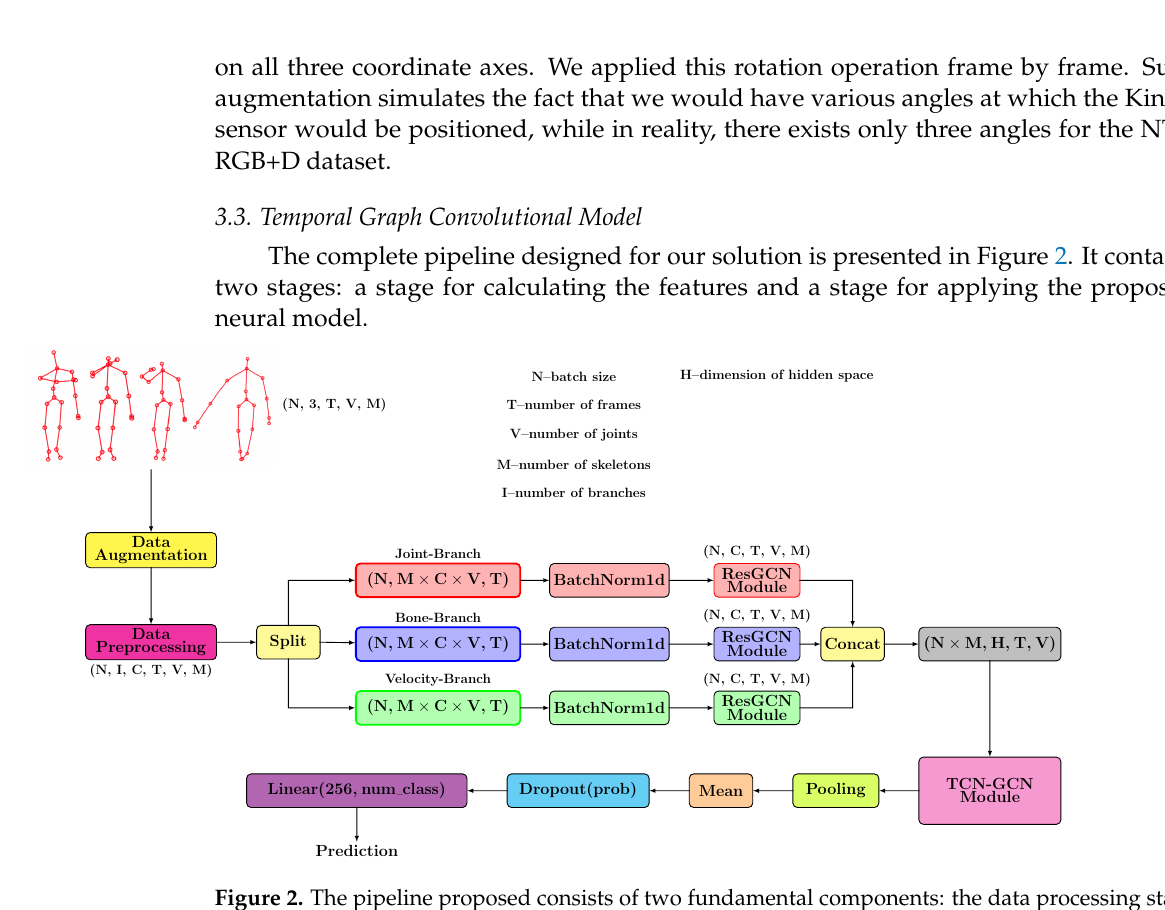
Figure 2. The pipeline proposed consists of two fundamental components: the data processing stage and the convolutional